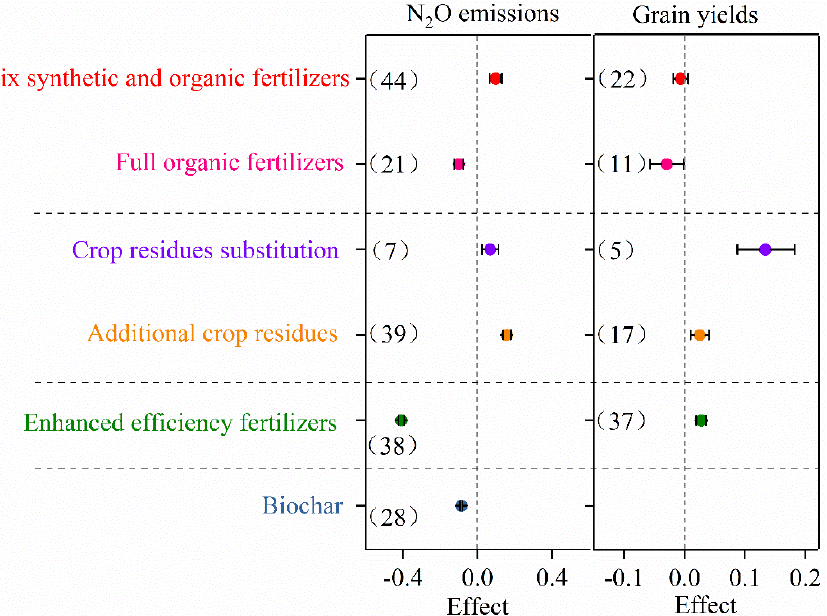
Figure 5. Impacts of various management practices on N 2 O emissions and grain yields. Data points are the weighted response ratio with 95% confidence intervals. Numerals indicate the sample size. Organic fertilizers refer to animal wastes, oil cake, and composts.